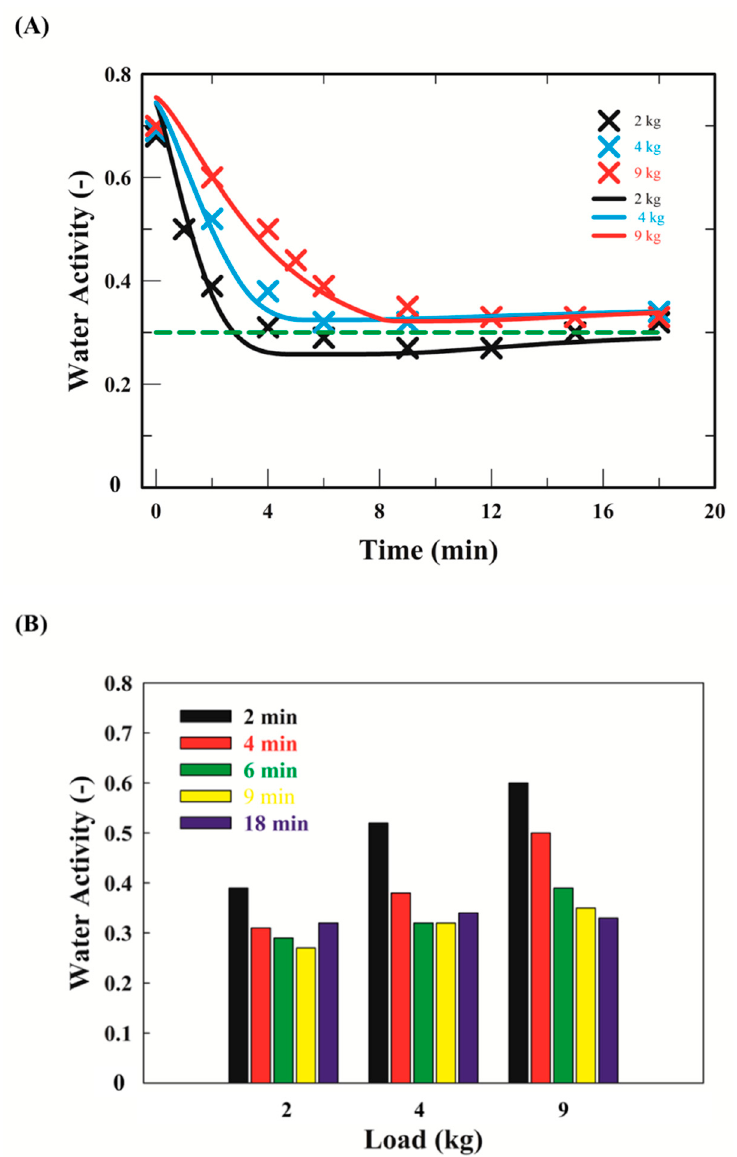
Figure 8. Profiles of the water activity ( A ) and the changes in the water activity ( B ) of wheat germ during drying with different WG loadings. The symbols represent the experimental data; the lines represent the simulated values.